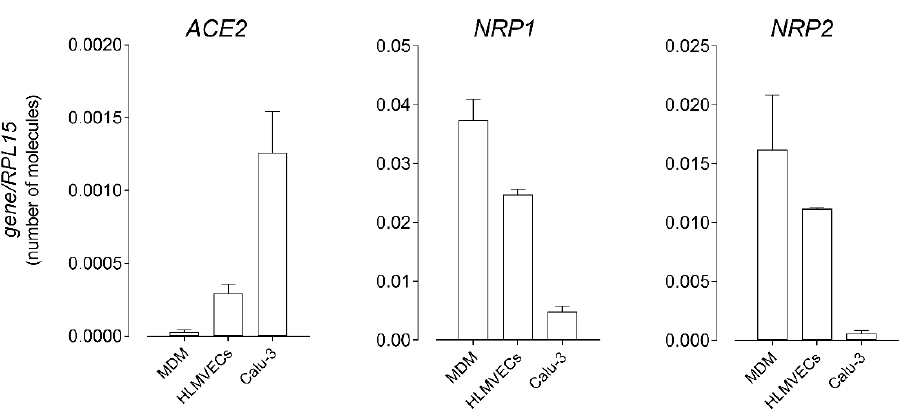
Figure 1. The absolute number of mRNA molecules for the indicated genes was calculated in human monocyte-derived macrophages (MDM), in human lung microvascular endothelial cells (HLMVEC), and in Calu-3 respiratory epithelial cells by means of RT-qPCR and expressed relative to that of the housekeeping gene RPL15, as described in Materials and Methods. Data are means ± SEM (Standard Error of Measurement) of six (MDM) or three (HLMVEC and Calu-3) determinations, each performed in duplicate.